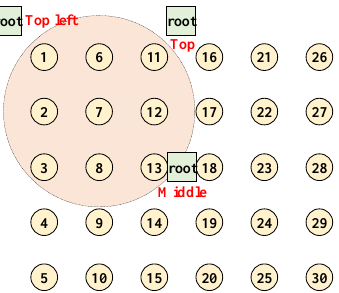
Figure 7. Three-simulation topology with change of root’s position: top-left, top, and middle. Last one is the random topology scenario where random topologies are generated by Cooja simulator.